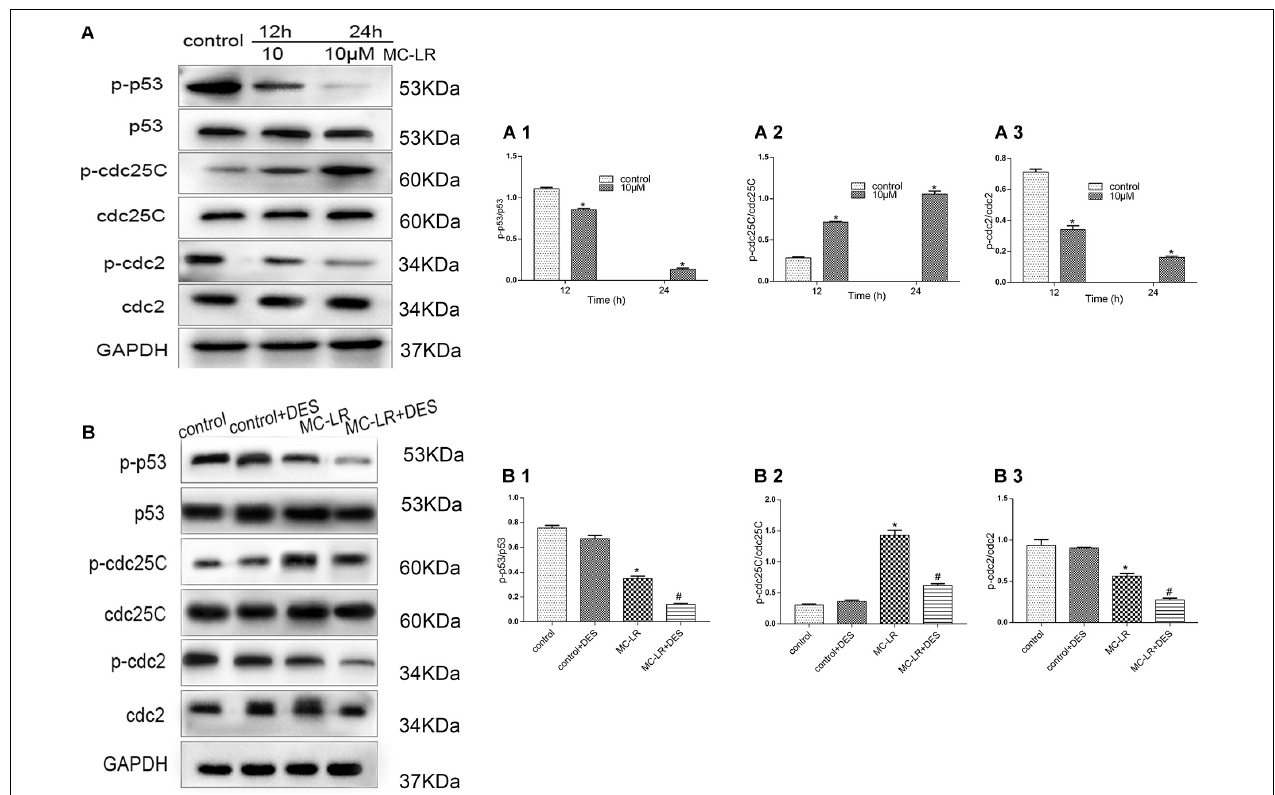
FIGURE 8 | MC-LR and HBx (cid:49) 32 modulate the phosphorylation of the p53, cdc25C, and cdc2 proteins through the activity of PP2A. The HBx (cid:49) 32 transfected HepG2 cells were incubated with 10 µ M MC-LR for 12 and 24 h, then the protein expression of p53, cdc25C, and cdc2 were detected by WB and the representative blots are shown as picture (A) . Bar graphs indicate means ± standard deviation from three independent experiments. Values were obtained by comparing phosphorylated bands with total protein bands, and the results were shown as (A1) Phospho-p53 (p- p53) and p53; (A2) phospho-cdc25C (p-cdc25C) and cdc25C; (A3) phospho-cdc2 (p-cdc2) and cdc2. The HBx (cid:49) 32 transfected HepG2 cells were pre-incubated with 10 µ M DES for 12 h and then exposed to 10 µ M MC-LR for 24 h, the control group was not exposed to MC-LR, then the protein expression of p53, cdc25C, and cdc2 was detected by WB and the representative blots are shown as picture (B) . Bar graphs indicate means ± standard deviation from three independent experiments. Values were obtained by comparing phosphorylated bands with total protein bands, and the results were shown as (B1) Phospho-p53 (p- p53) and p53; (B2) phospho-cdc25C (p-cdc25C) and cdc25C; (B3) phospho-cdc2 (p-cdc2) and cdc2. * P < 0.05 vs. 0 µ M MC-LR; # P < 0.05 vs. 0 µ M MC-LR and